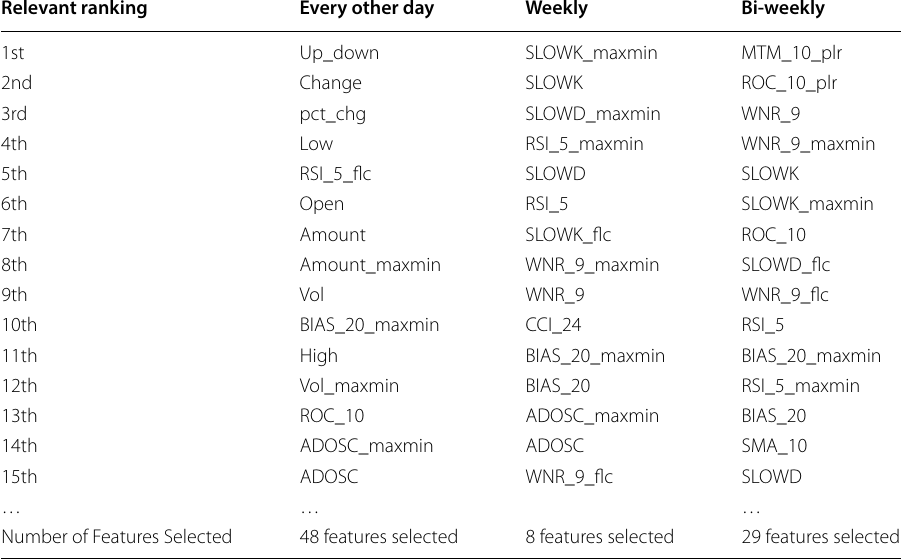
Table 3 Effective features corresponding to term lengths Relevant